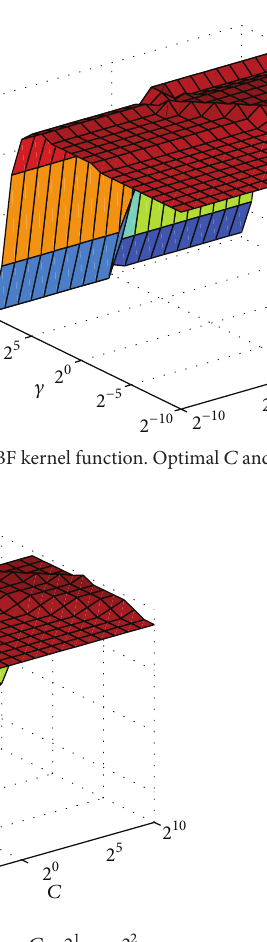
(c) SKF kernel function. Optimal 𝐶 and 𝛾 are 𝐶 = 2 1 , 𝛾 = 2 2 Figure 14: The CV accuracy with 𝐶 and 𝛾 for polynomial, RBF, and SKF kernel